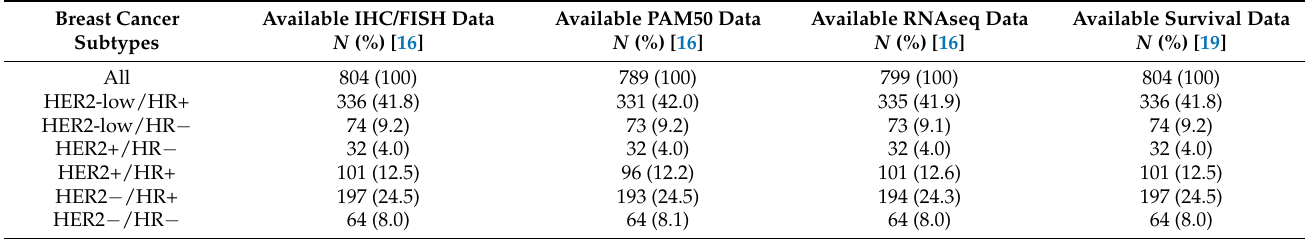
Table 1. Characteristics of samples included in the analysis, according to availability of IHC/FISH, PAM50, RNAseq and survival